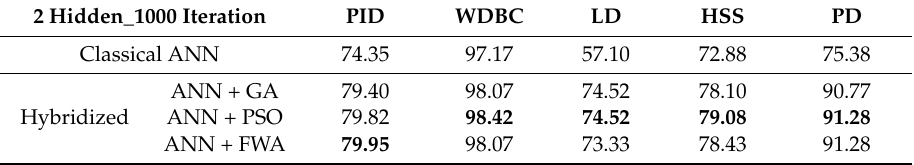
Table 3. 2-hidden–layer ANN hybridized with optimization algorithms GA, PSO, and FWA for 1000